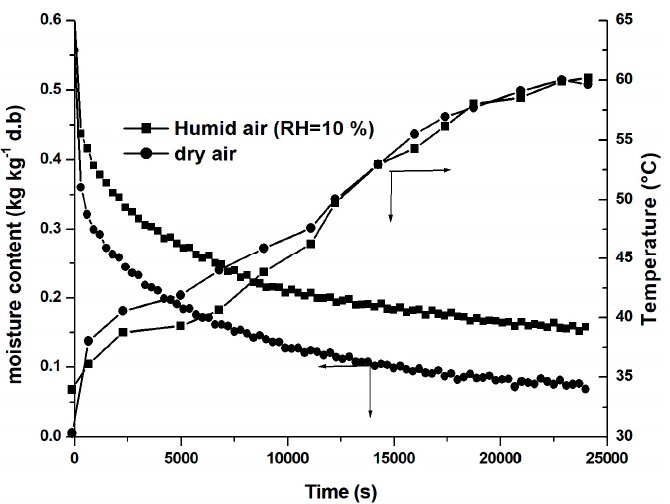
Figure 8. The effect of the relative humidity on the evolution of moisture content and the tempera- ture of the thin layer of corn; V = 1 m·s − 1 , T = 60 °C. of the thin layer of corn; V = 1 m · s − 1 , T = 60 ◦